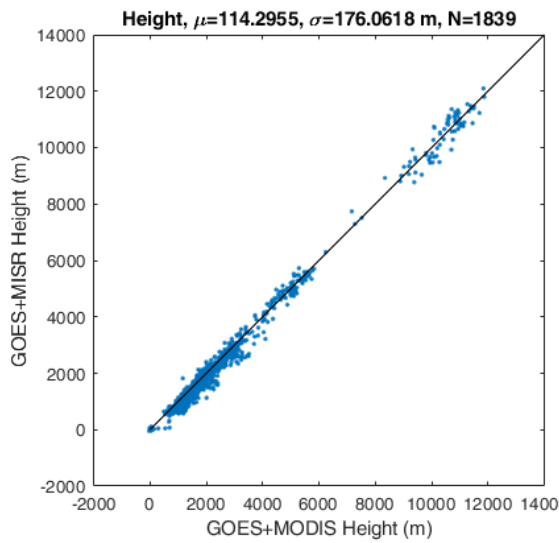
Figure 19. Jointly retrieved wind heights are compared between the MODIS-GOES and MISR-GOES cases with robust statistic on their differences (mean µ and standard deviation σ , over sample size N). The heights are with respect to the WGS84 ellipsoid. The MODIS granule is MOD2018196.1700.061 and is simultaneous with MISR Path 24, Orbit 98797.